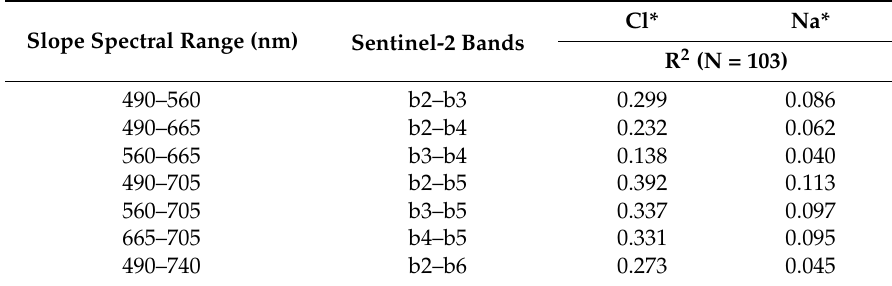
Table 6. Coefficient of determination between calculated slope/ratio based on Sentinel-2 configuration and the Cl and Na contents of the plant samples. * p value <